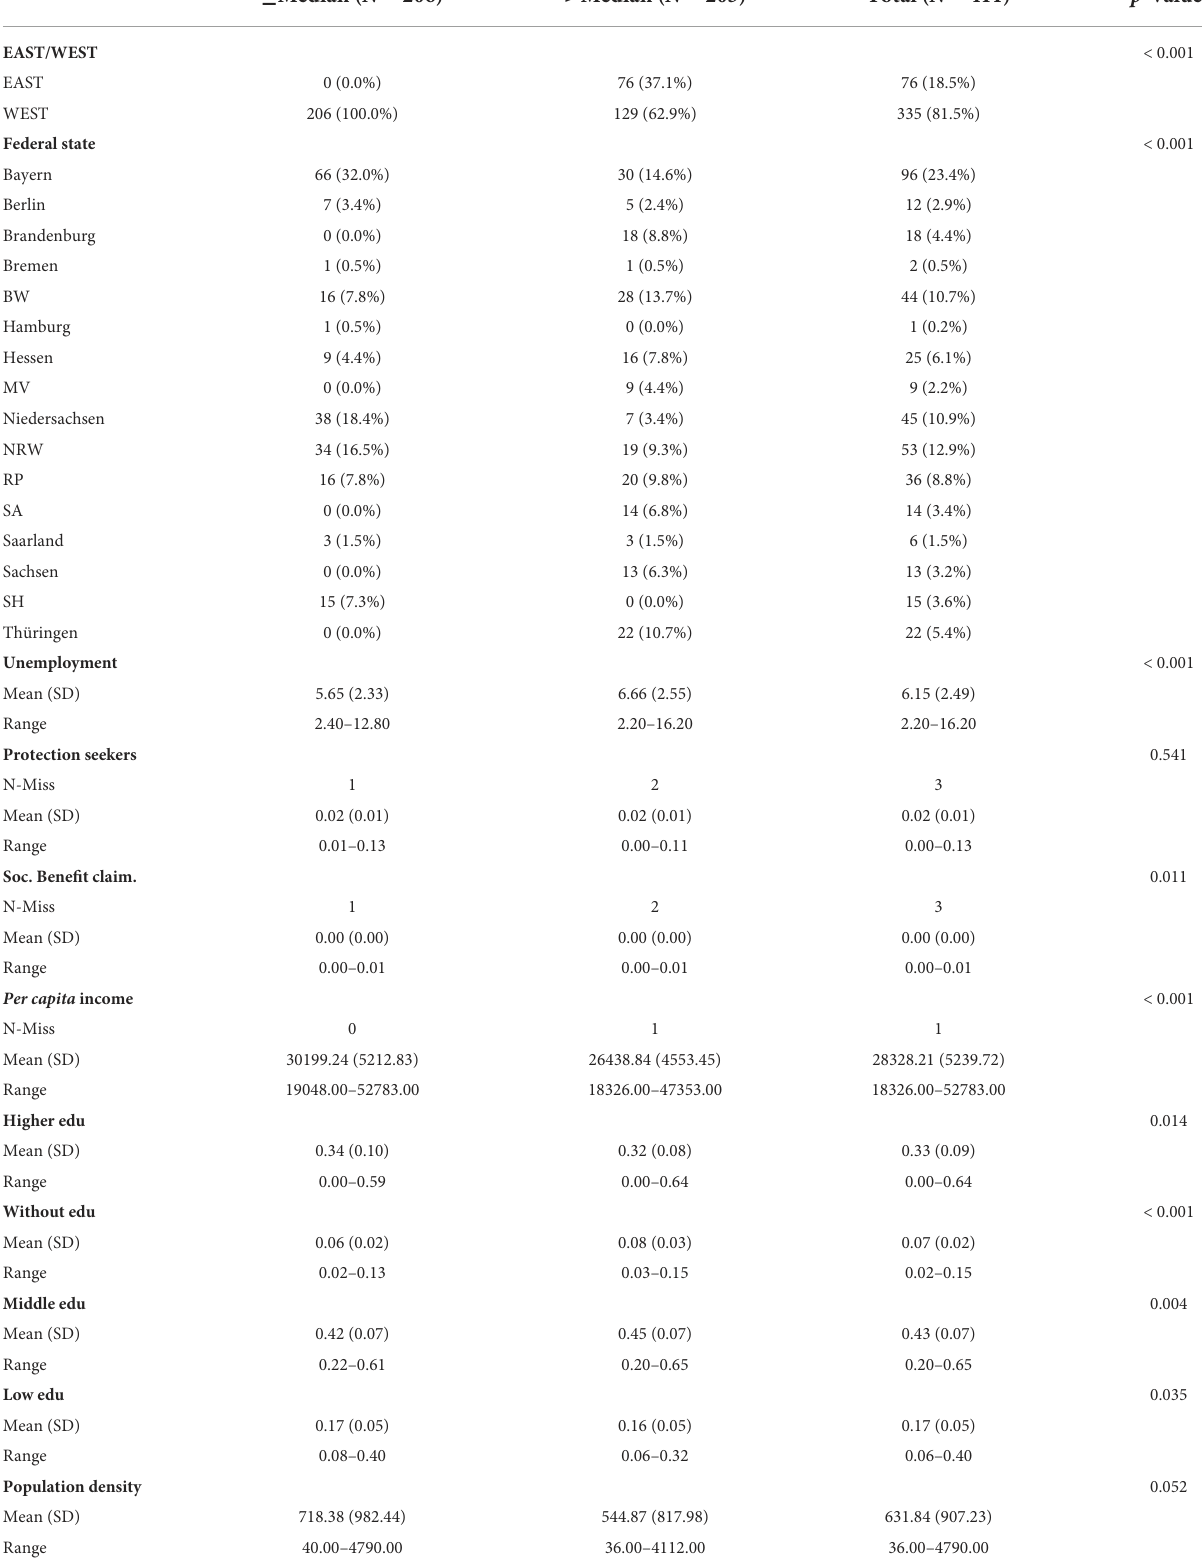
TABLE 1 Summary table of characteristics (first column) of rural districts with AfD share of vote below the median value taken over all 411 German districts (second column) and above median (third column), respectively. For an explanation of the characteristics confer the Methods